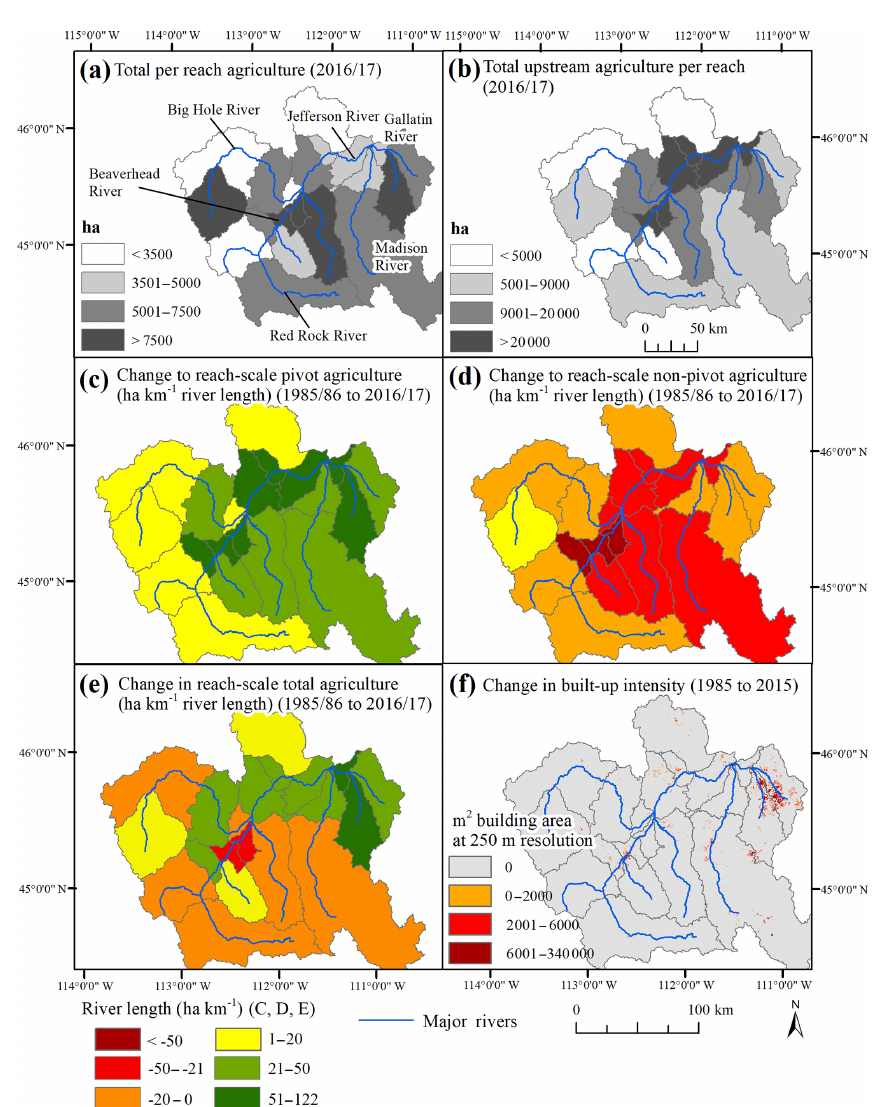
Figure 7. Changes in agricultural and development characteristics across Upper Missouri River headwaters basin between 1985–1986 and 2016–2017, including (a) total per reach agriculture (2016–2017), (b) total agriculture within and upstream of each reach (i.e., ac- cumulated agriculture; 2016–2017), (c) change in the extent of center-pivot irrigation (1985–1986 to 2016–2017), (d) change in the extent of non-pivot irrigation (1985–1986 to 2016–2017), (e) change in total per reach agriculture (1985–1986 to 2016–2017), and (f) change in built-up intensity, defined as the summed building area at 250m resolution (1985 to